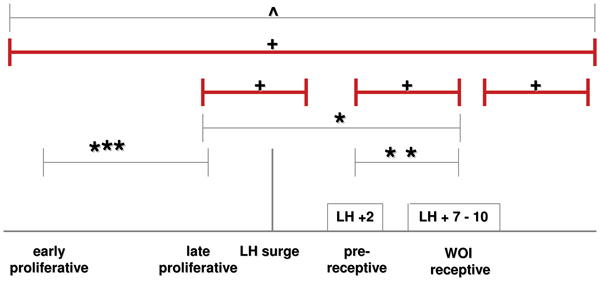
Schematic representation of microarray studies comparing cycle phases in women and non-human primates. (See text). Symbols correspond to citations: * [5,7,9]; ** [6,8,11,12]; *** [10]; ^[13]; + [14]. With permission from reference [14].